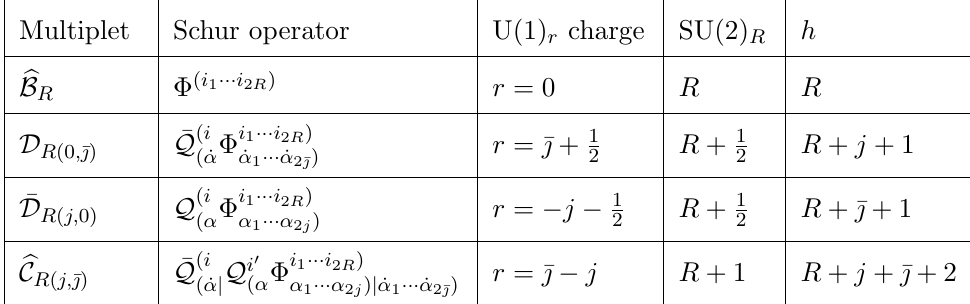
Table 2 . Schur operators in Schur multiplets with their U(1) r and SU(2) R charges. Here (cid:8) is the superconformal primary (cid:12)eld of the multiplet. The rightmost column shows the holomorphic dimension of the corresponding operator in the two-dimensional chiral